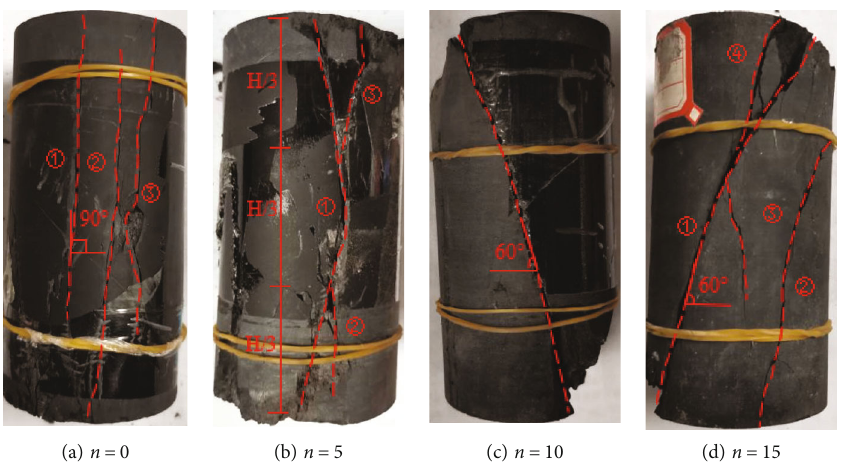
Figure 6: Failure characteristics of carbonaceous mudstone sample.